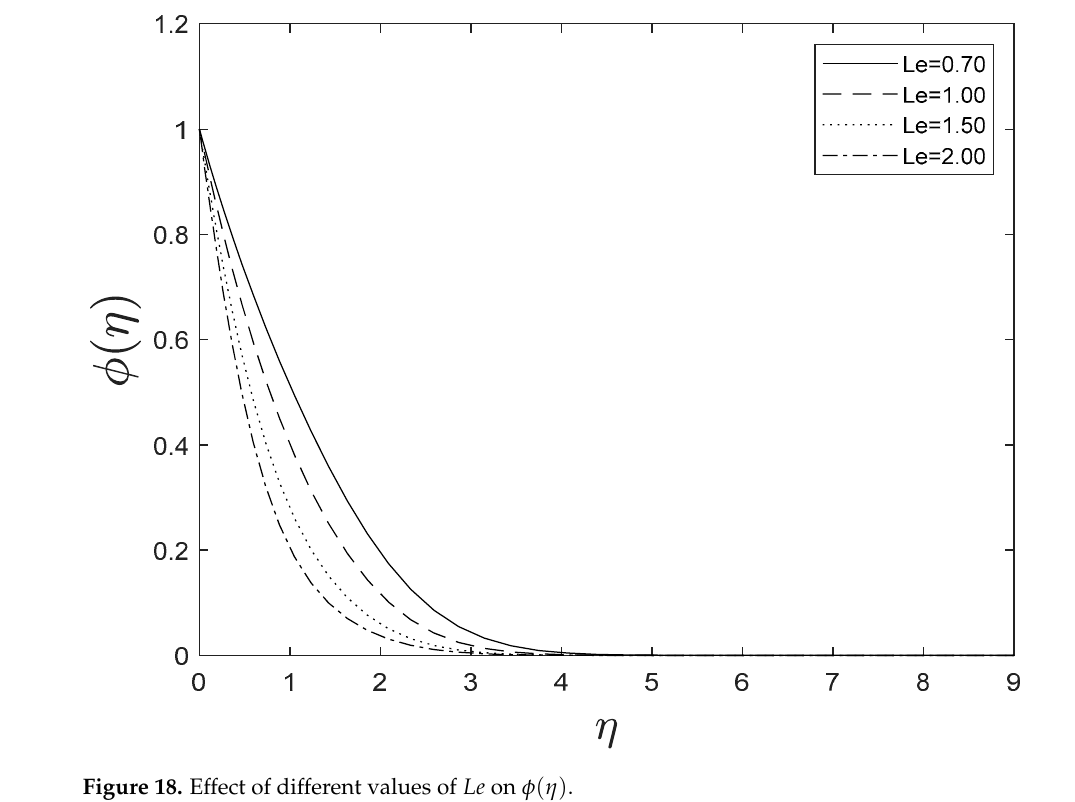
Figure 18. Effect of different values of Le on φ ( η ) .